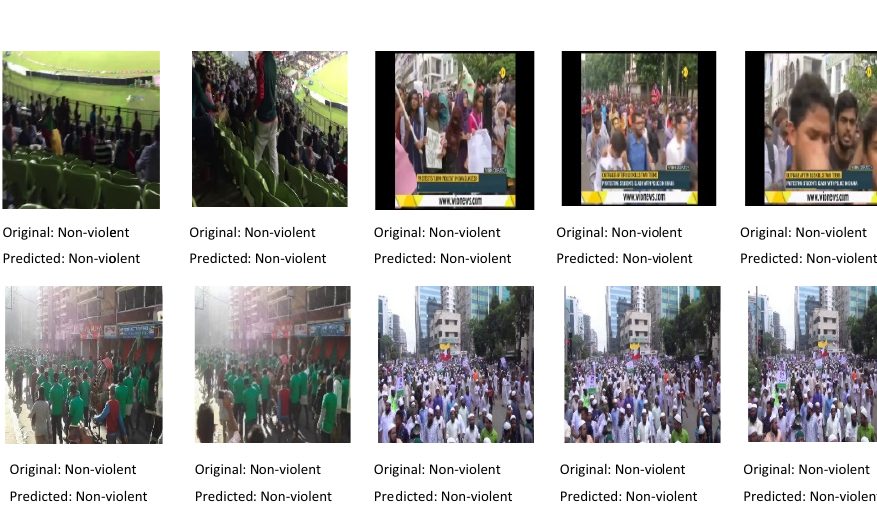
Fig. 19. Prediction on non-violent video